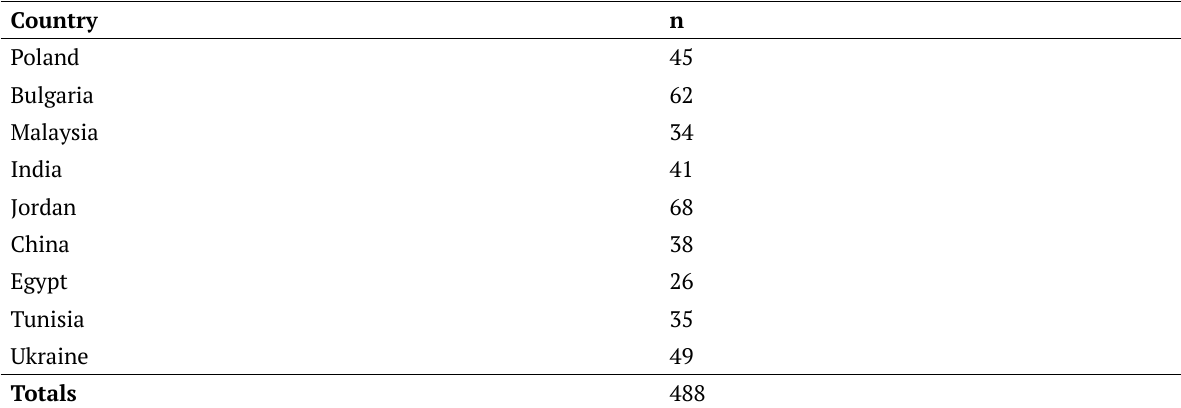
Table 1. Distribution of study participants